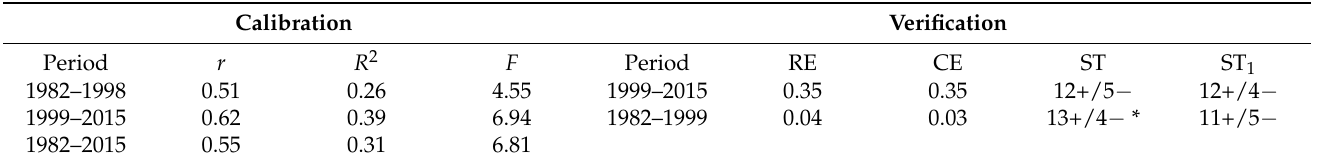
Table 3. Statistics of the calibration and verification tests of the NDVI total reconstruction. Calibration Verification